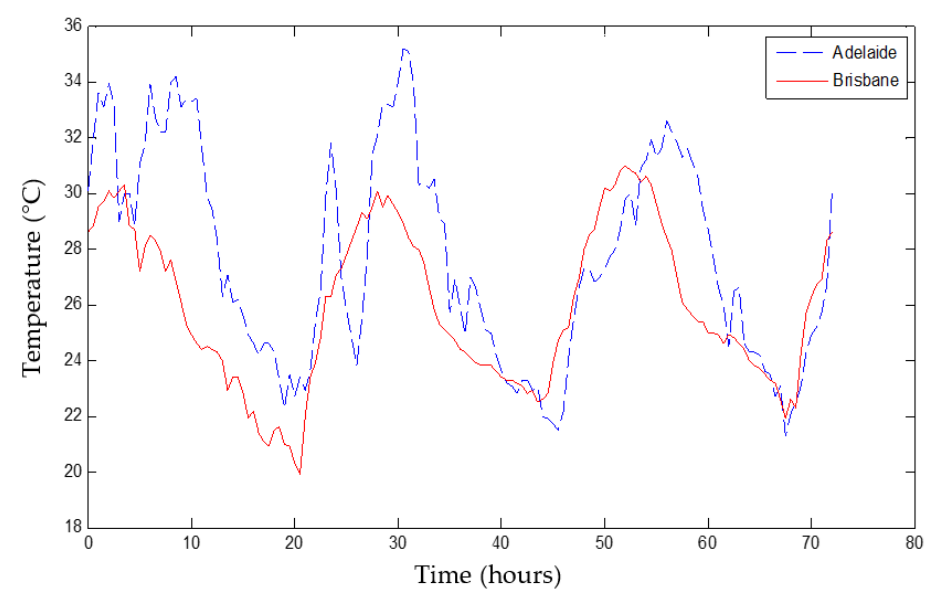
Figure 6. An example of ambient temperature in Adelaide and Brisbane on 3 consecutive summer days.